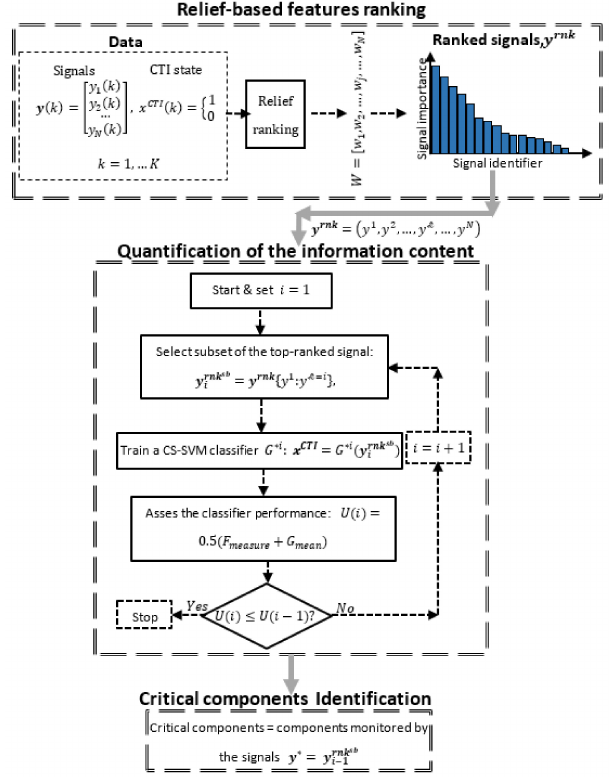
Figure 2. Schematic representation of the proposed